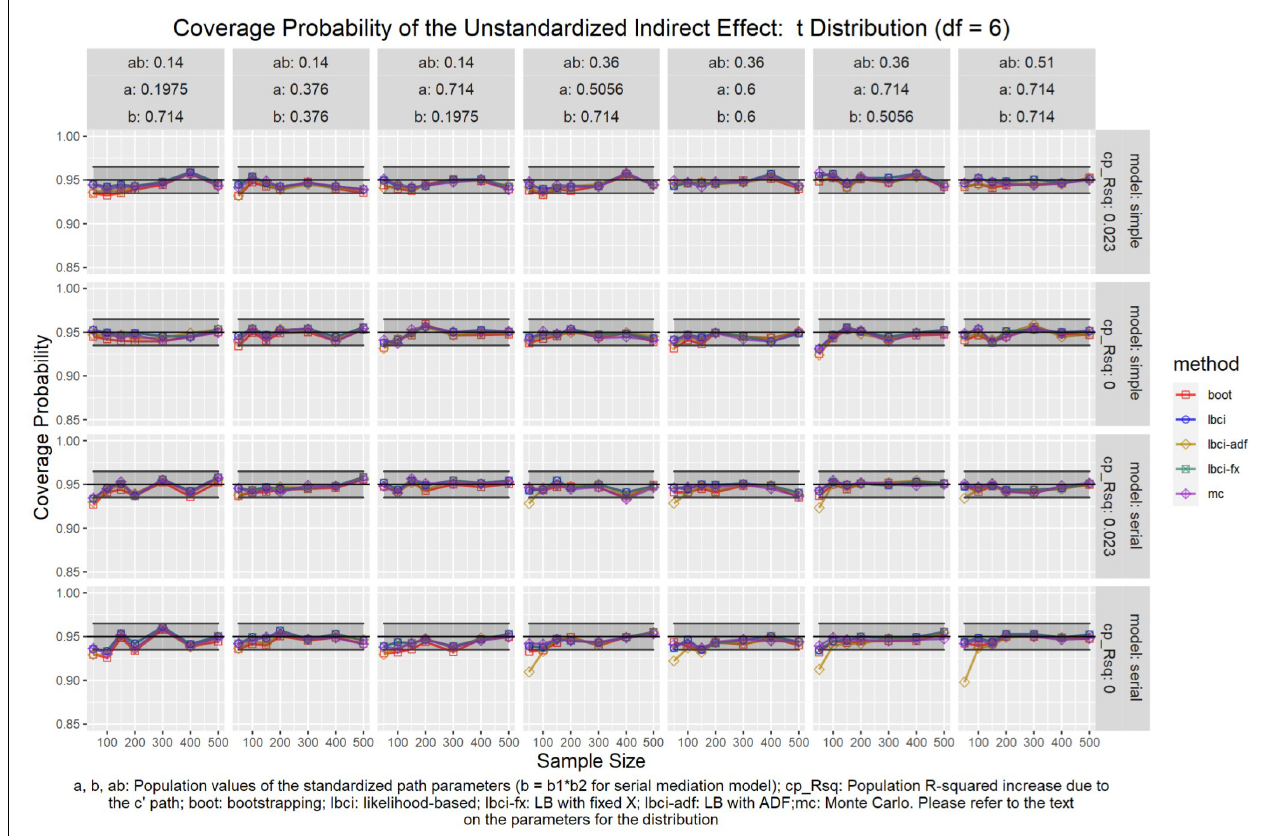
FIGURE 9 | t (6) Distribution (Unstandardized Indirect Effect). a, b, ab: Population values of the standardized path parameters (b = b1 × b2 for serial mediation model); cp_Rsq: Population R-squared increase due to the c (cid:48) path; boot: bootstrapping; Ibci: likelihood-based; Ibci-fx: LB with fixed X; Ibci-adf: LB with ADF;mc: Monte Carlo. Please refer to the text on the parameters for the